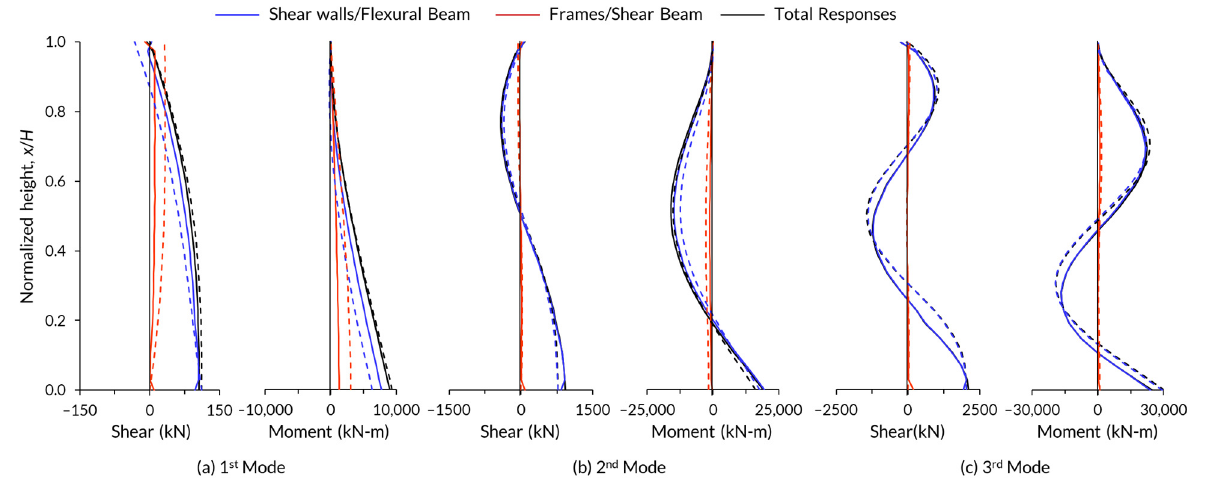
Figure 6. Force responses of building B1 in the x direction.